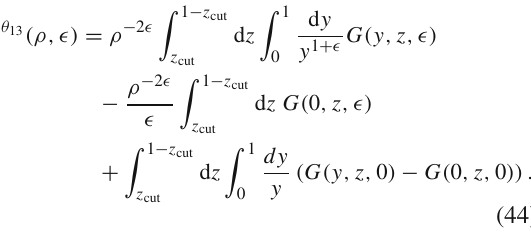
Fig. 2 An illustration of the kinematic parametrisation in the C F T R n f gluon decay